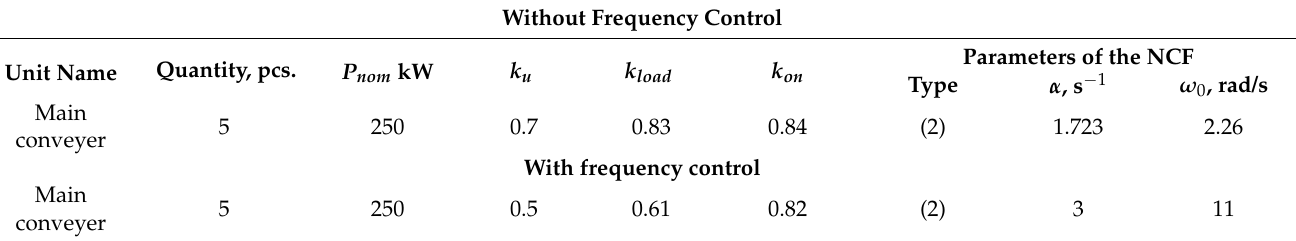
Table 10. Reference information for an ED.